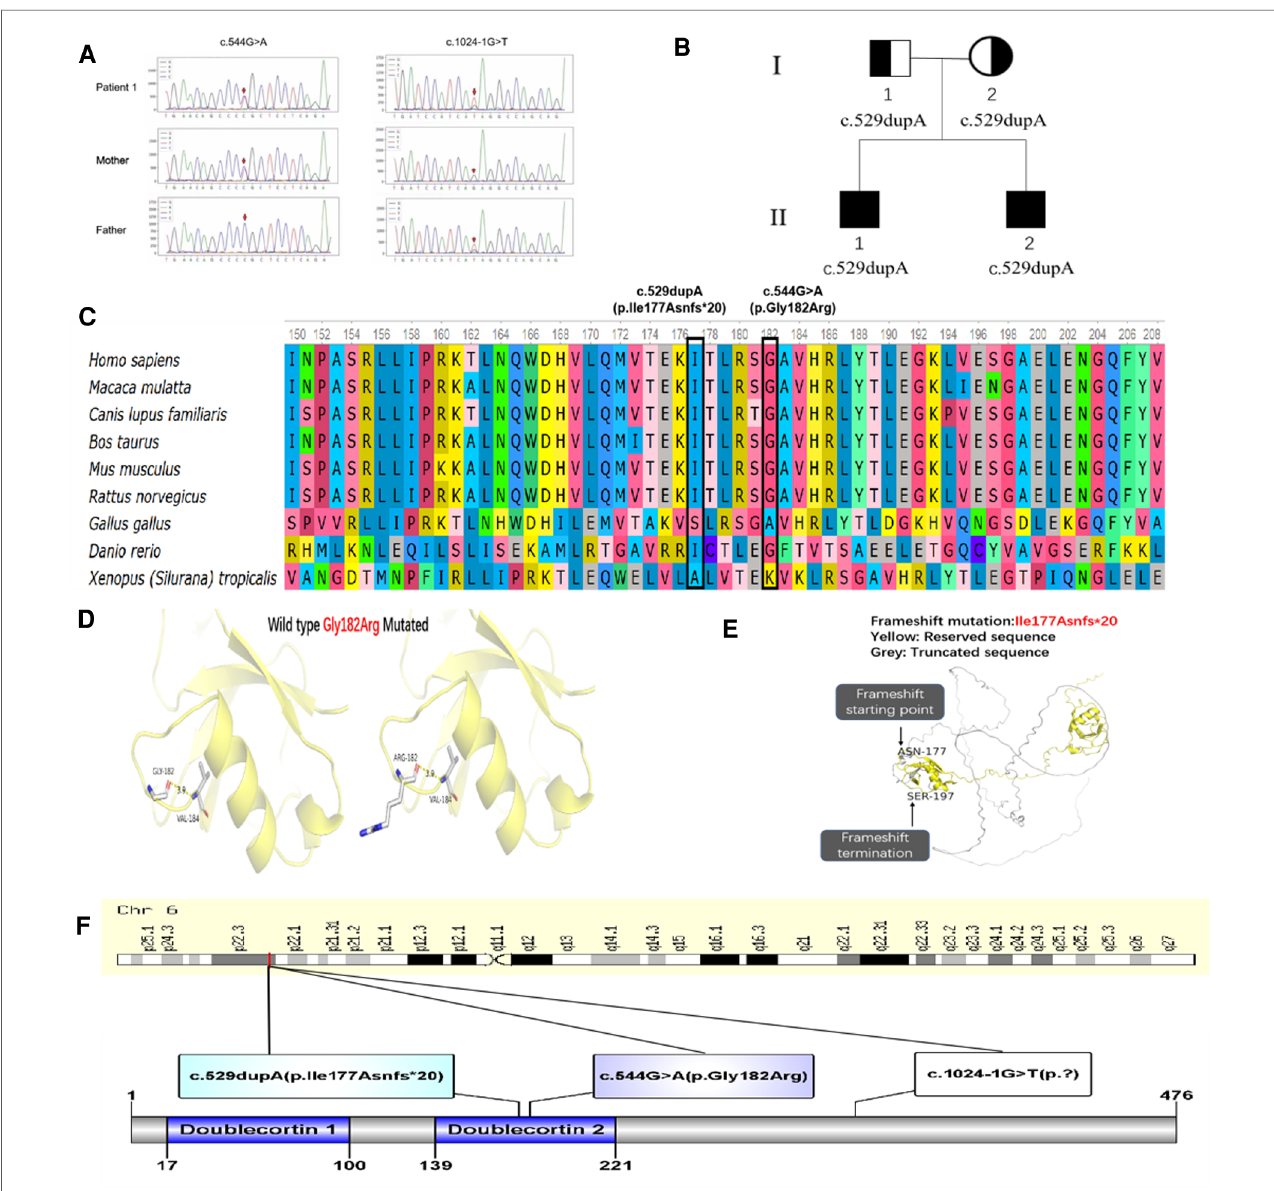
FIGURE 2 ( A ) Sanger sequencing con fi rmation of c.1024-1G>T and c.544G>A mutation of DCDC2 in patient 1 and his parents. ( B ) Pedigree of patient 3 and 4, I-1 was the father, I-2 was the mother, II-1 was patient 3, II-2 was patient 4. ( C ) Conservation status of amino acid residues of the two variants across various species in four patients. ( D ) Wild and mutated types of the p. Gly182Arg variant in patient 1 compared by PyMol. ( E ) Spatial conformation of the frameshift mutation (p. Ile177Asnfs*20) showed by protein modeling. ( F ) Illustration of DCDC2 protein domains, location of amino acid changes in four